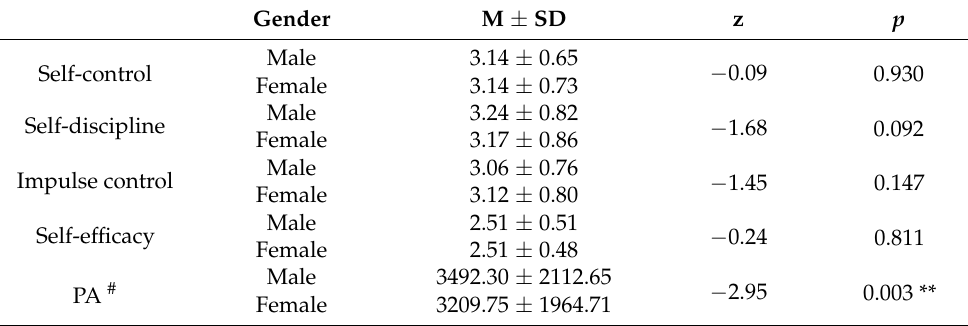
Table 5. Independent sample z-test of gender difference.